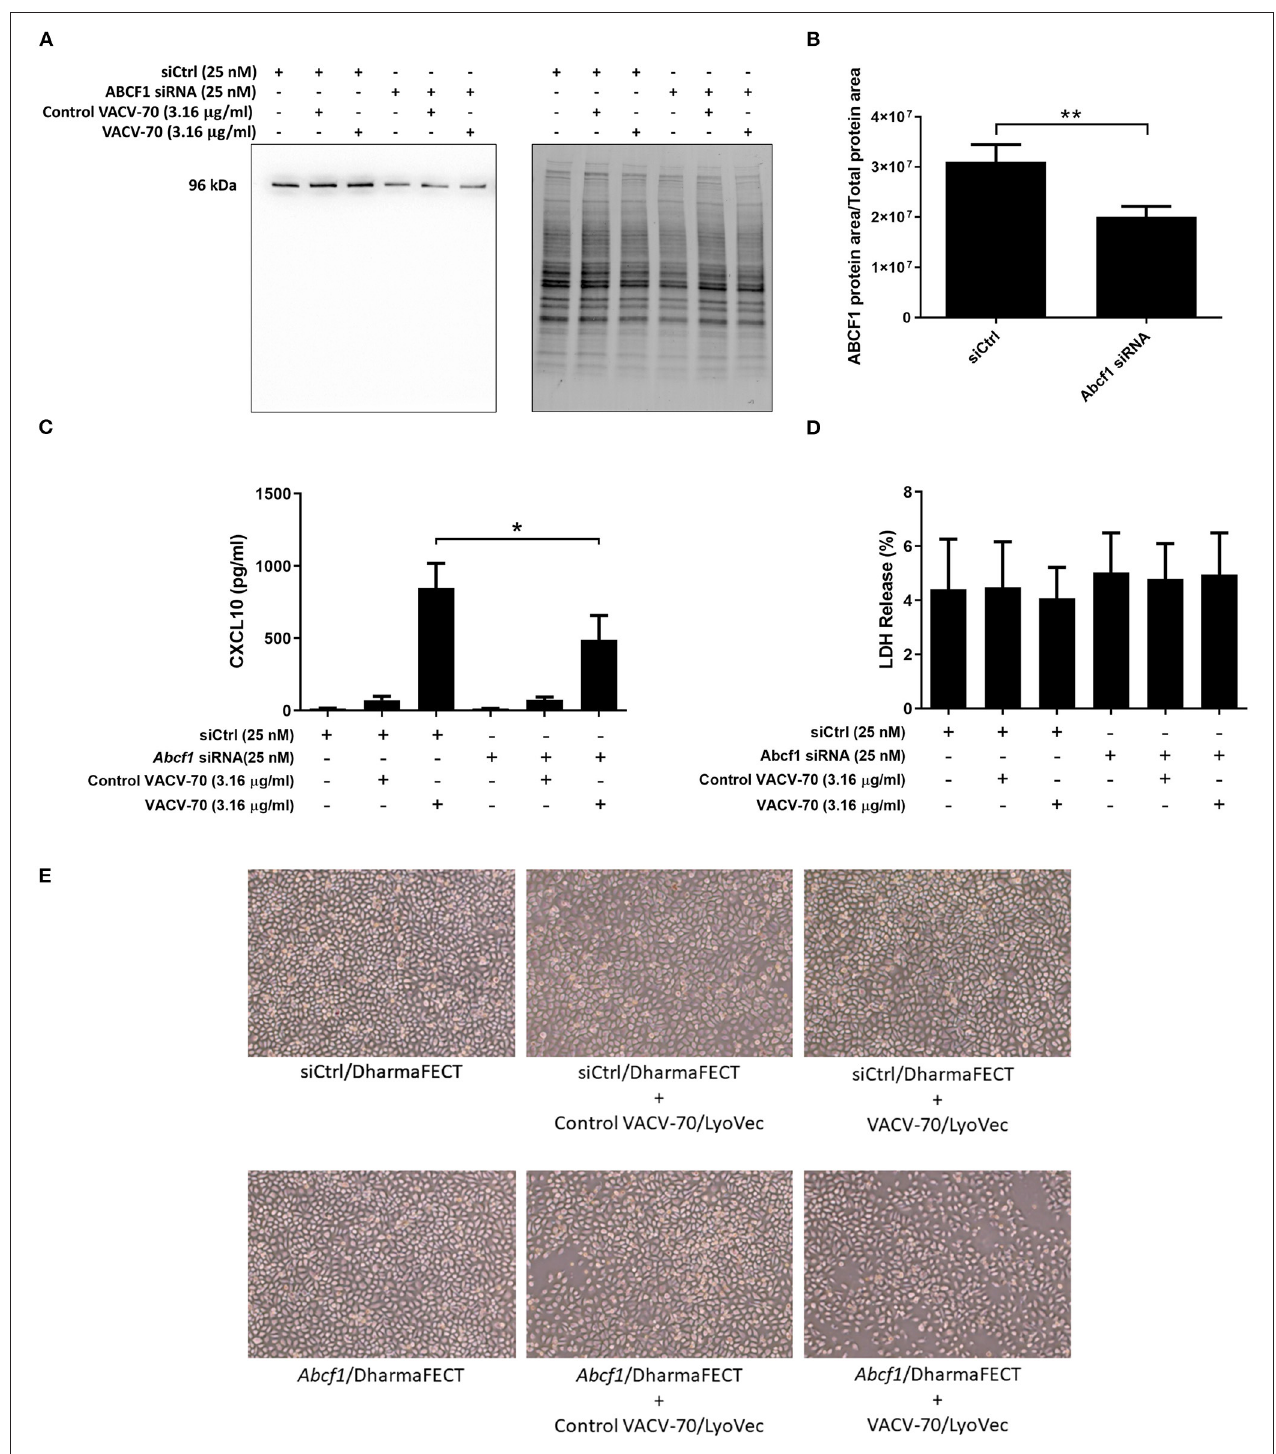
FIGURE 4 | Reduced expression of ABCF1 under VACV-70 stimulated conditions attenuates CXCL10 secretion. (A) Immunoblot confirming siRNA-mediated knockdown of ABCF1 protein expression in HBEC-6KT cells under experimental conditions of VACV-70 challenge. (B) Quantification of ABCF1 protein expression following siRNA treatment. (C) VACV-70 (3.16 µ g/ml)-induced CXCL10 protein production for HBEC-6KT cells with ABCF1 siRNA treatment. Black bars: siCtrl treated. Gray bars: ABCF1 siRNA treated. (D) LDH quantification as a measure of cell viability following VACV-70 and siRNA treatment. (E) Phase-contrast microscopy (4X magnification) of HBEC-6KT following VACV-70 and siRNA treatment. All studies n = 3. * p < 0.05 and ** p < 0.01.